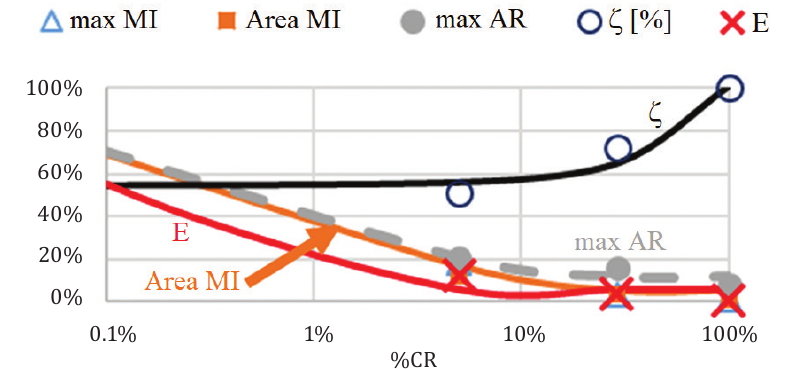
Figure 2. CR impact on noise (AR) and mechanistic response (MI, ζ , and E ) elaborated from (Praticò et al., 2021b,